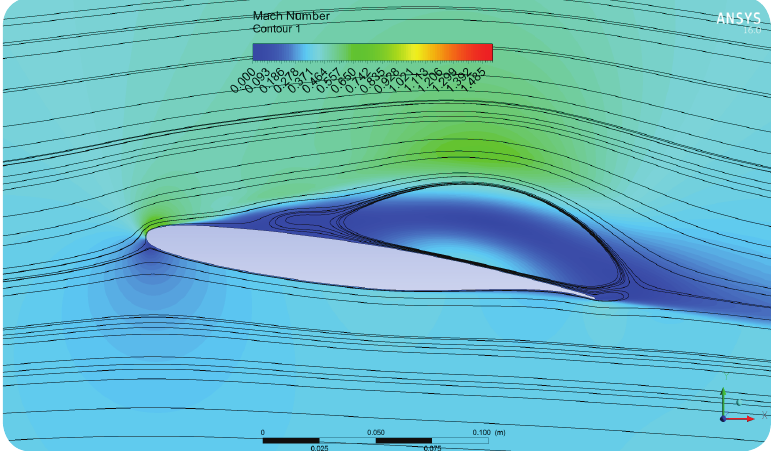
Figure 32. Mach contour, pitch motion α (t) = 3 + 3 sin( w t), frequency = 3 Hz, Mach = 0.4, Alpha = 5°.